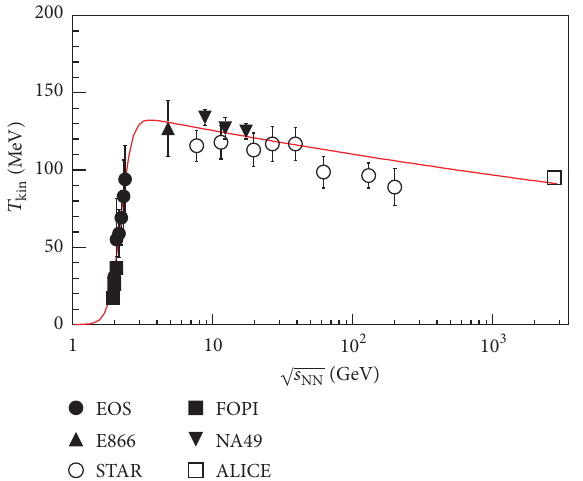
Figure 2: The averaged radial flow ⟨𝛽⟩ as a function of centre-of- . Data are from [41, mass energy √𝑠 NN